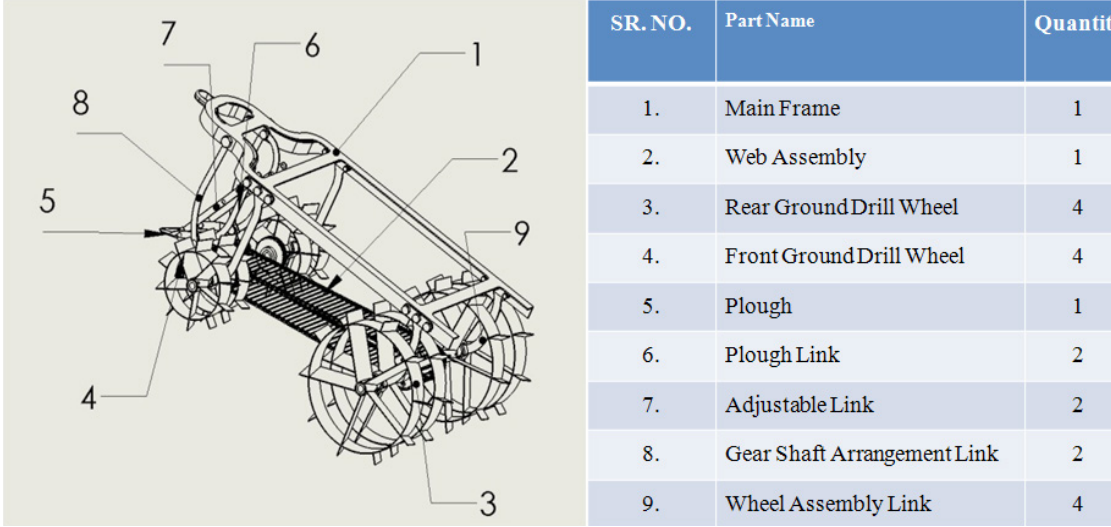
Figure 1: Block diagram of root crop harvesting